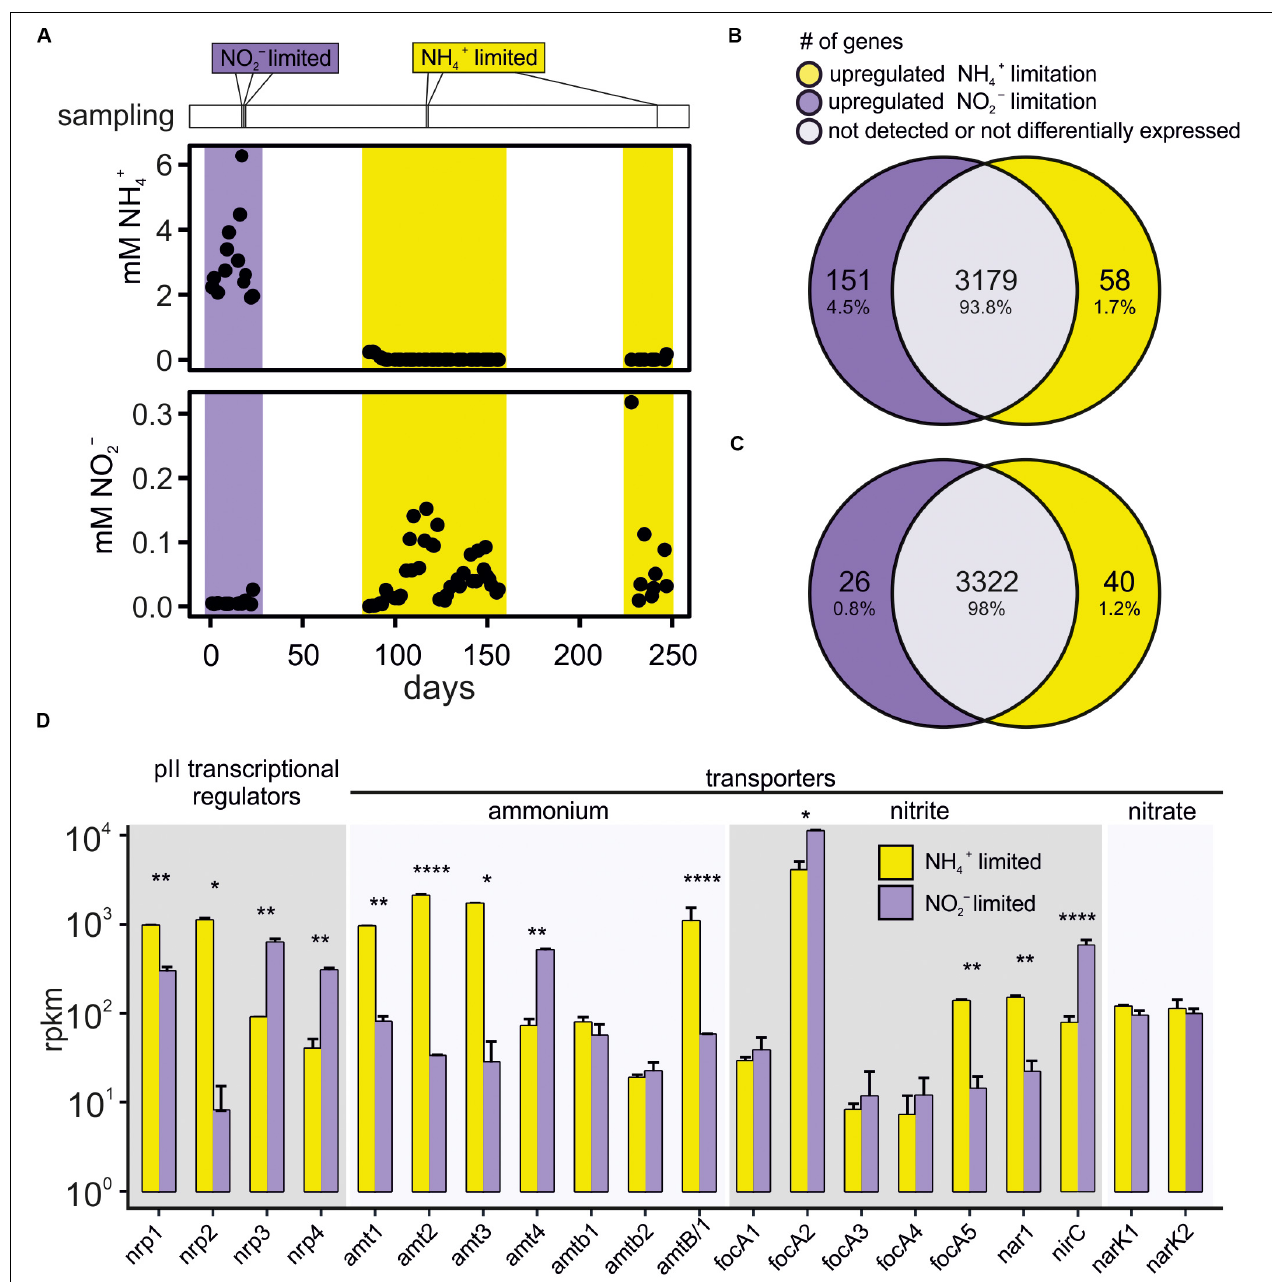
FIGURE 1 | (A) Measured ammonium and nitrite levels in the K. stuttgartiensis MBR1 bioreactor and sampling times for transcriptomic analyses, indicated with vertical lines above the graph. (B) Venn diagram showing the number of genes that were exclusively expressed during either ammonium- (yellow) or nitrite-limitation (purple), and the genes that were expressed in both conditions. (C) Venn diagram showing only the genes significantly upregulated > 1.5-fold in either ammonium- (yellow) or nitrite-limitation (purple). The overlap includes all genes with either (1) very low expression levels (basemean < 4), or (2) expression levels that were within 1.5-fold change between ammonium- and nitrite limited conditions, or (3) with changes in expression levels that were below the significance level (padj > 0.05). Note that the 707 genes not expressed in either condition are not included in the Venn diagrams. (D) Bar graph of P II regulator genes (nrp1-4), ammonium transporter genes (amt1-4, amtb1-2, and amtB/1), nitrite transporter genes (focA1-5 and nar1), nitrate transporter genes (narK1-2) and their expression levels under both ammonium- (yellow) and nitrite (purple) limited growth. Statistical significance ns: * p = 0.05, ** p = 0.01, **** p = 0.0001. RPKM values corresponding to each bar are shown in Supplementary File 2